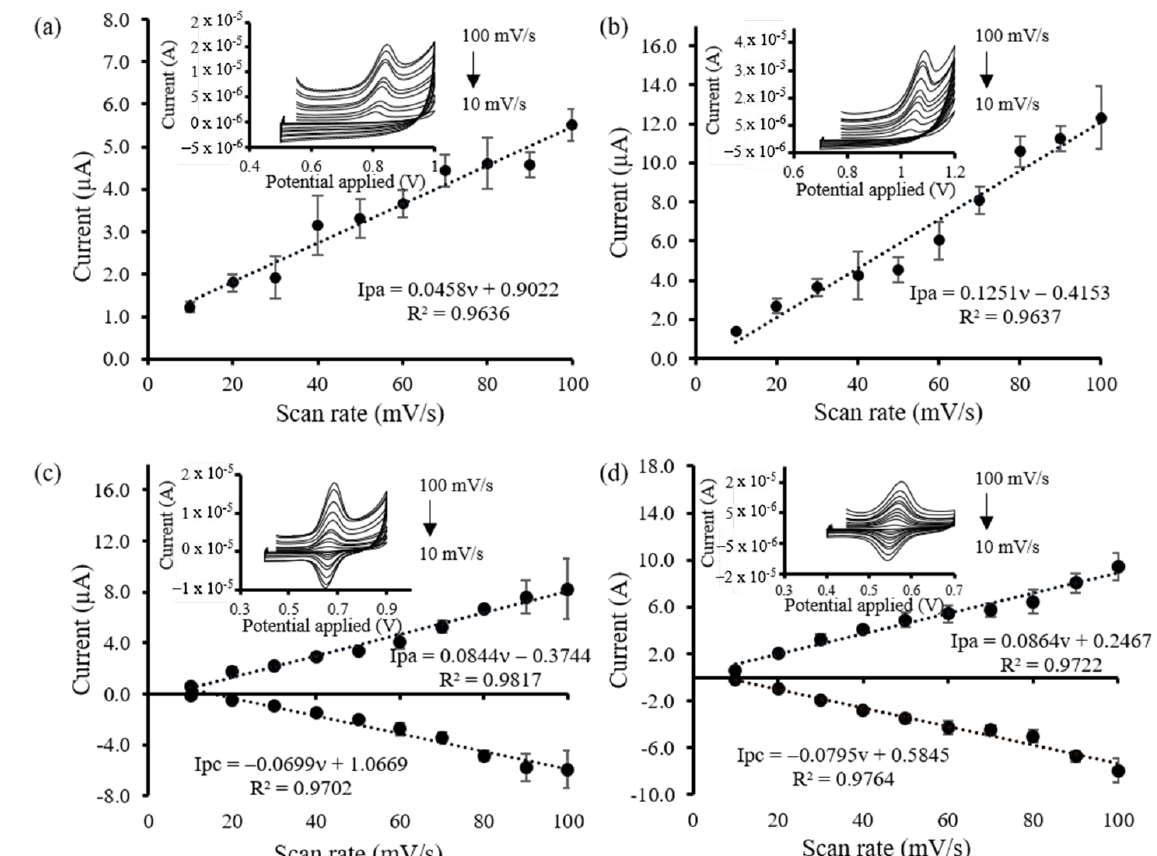
Figure 5. Linear relationship between scan rate and current response of amaranth ( a ), tartrazine ( b ), sunset yellow ( c ), and carminic acid ( d ). Insets represent obtained cyclic voltammograms at different scan rates.